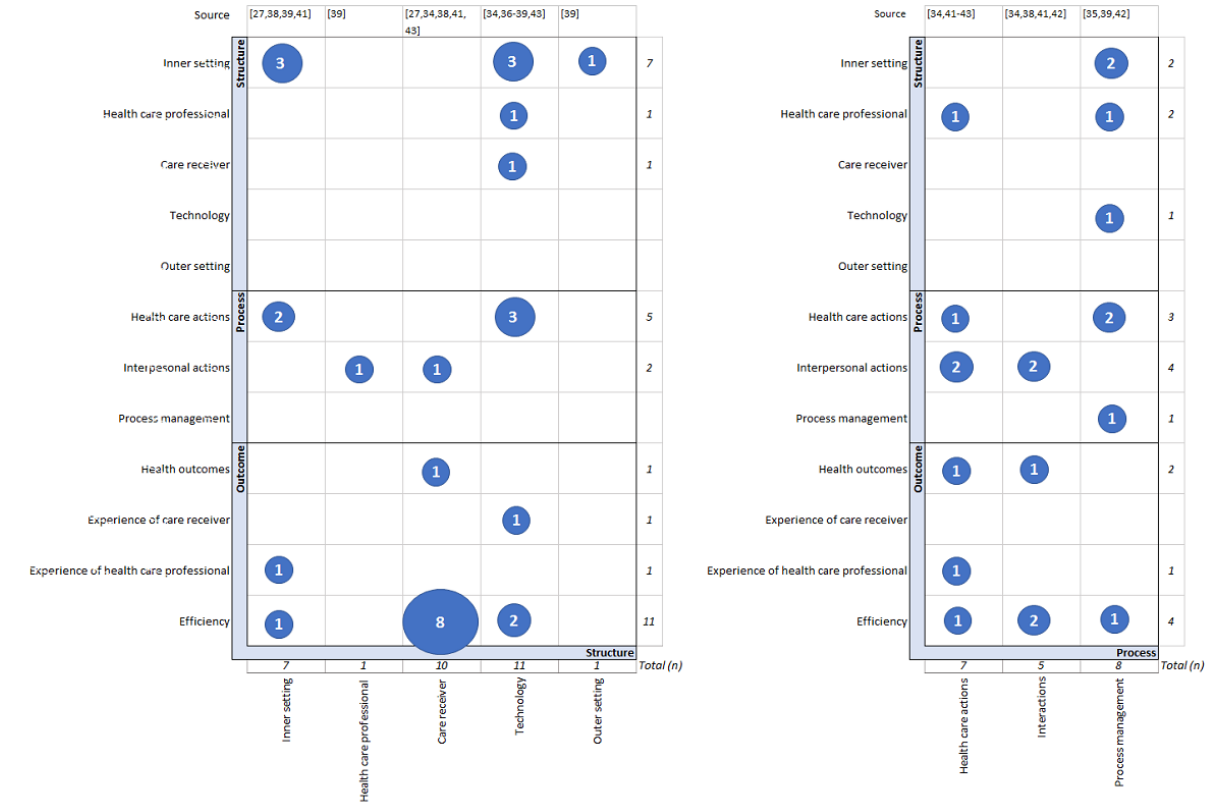
Figure 6. Interactions among indicators within themes and categories. The numbers within the blue circles represent the number of noted interactions among indicators within the themes. The x-axis represents the antecedent, and the y-axis represents the (intermediate)